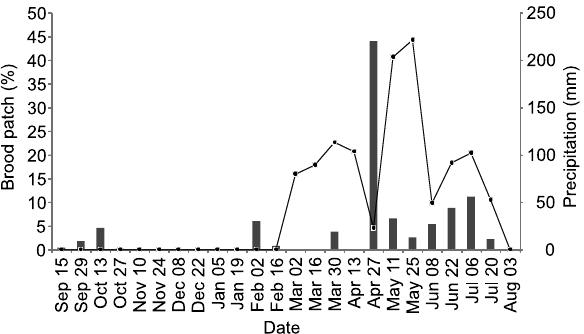
Figure 1. Occurrence of brood patches ( ● ) and accumulated precipitation (bars). Percentage of individuals with brood patches was calculated per netting event and based on the number of captures. Precipitation was calculated based on the interval of 14 days between the netting sessions. Sampling occurred between Instituto Nacional de Meteorologia, Mossoro Station, A318,